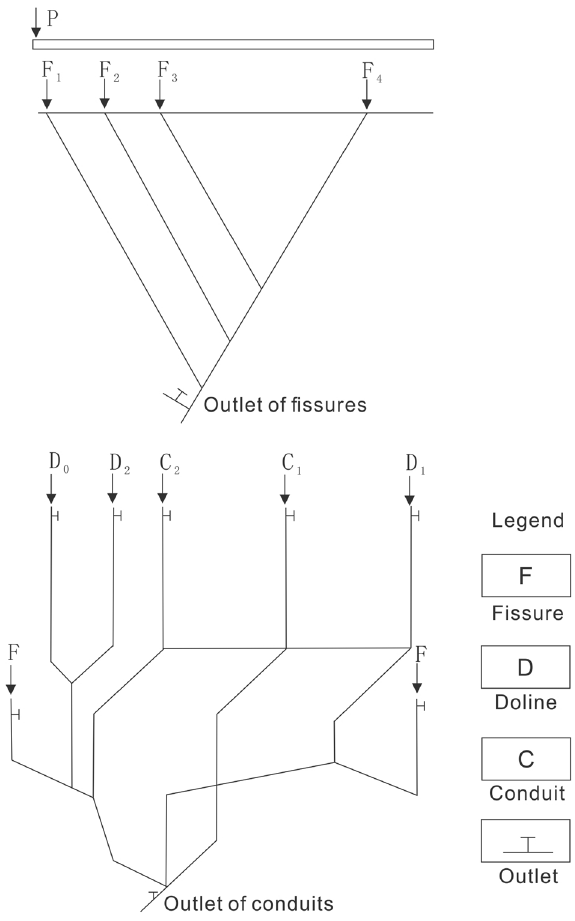
Figure 3. Injection points of fissures and